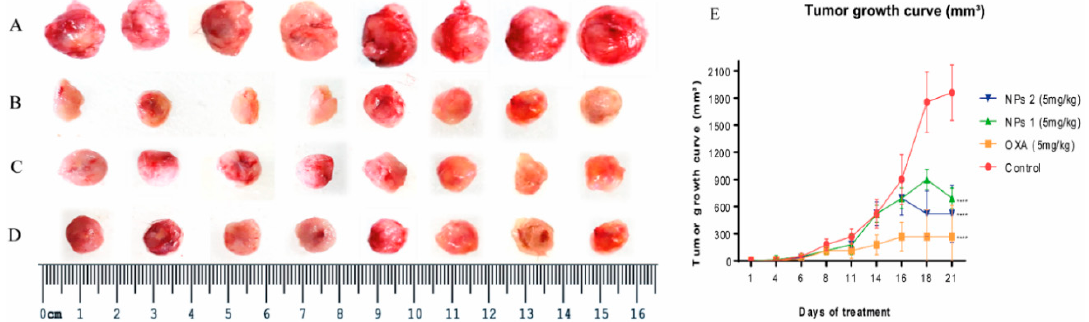
Figure 6. Morphology of all the tumors collected from ( A ) control, ( B ) OXA (5 mg/kg), ( C ) NPs 1 (5 mg/kg), and ( D ) NPs 2 (5 mg/kg) mice. Tumor growth curve of the Balb/c xenografts with different treatments ( E ). All treatment groups were compared to the negative control group (**** p < 0.0001).